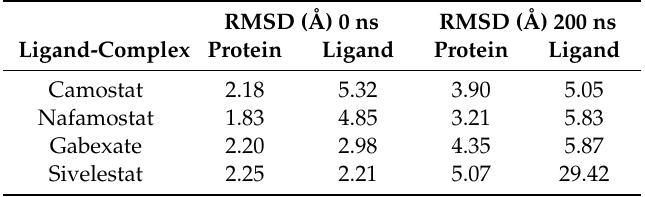
Figure 8. Protein-Ligand RMSD over the 200 ns MD simulation for ( A ) camostat ( B ) nafamostat ( C ) gabexate ( D ) sivelestat.